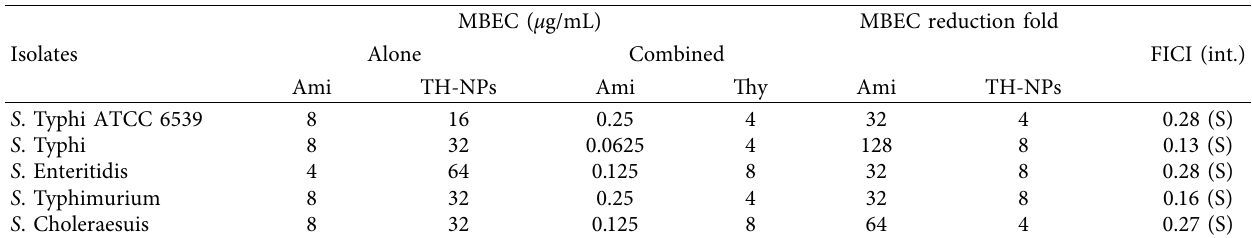
Table 2: Minimum bioflm inhibitory concentration (MBIC) of amikacin and thymol-loaded PLGA and the fractional inhibitory con- centration index (FICI) of combination against S. enterica serovars.